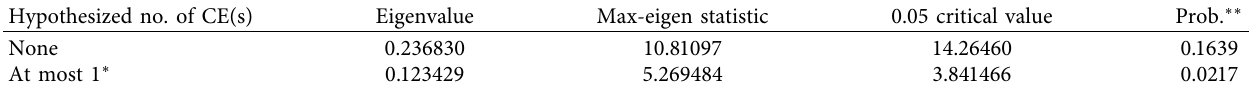
Table 5: Johansen cointegration test results.